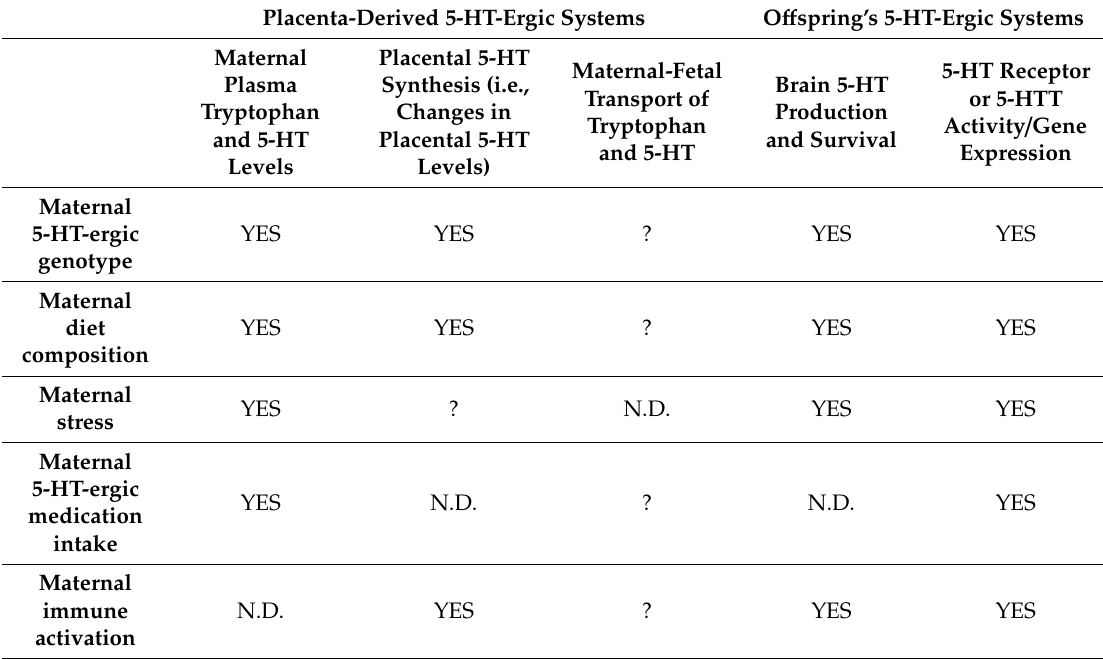
Table 4. Gestational factors influence multiple 5-HT-ergic systems. When the association between the gestational factor and the 5-HT system is proven by scientific studies, we report ‘YES’. When the association is theorized but not yet proven, we report ‘?’. When the association is not investigated, we report ‘Not Determined’